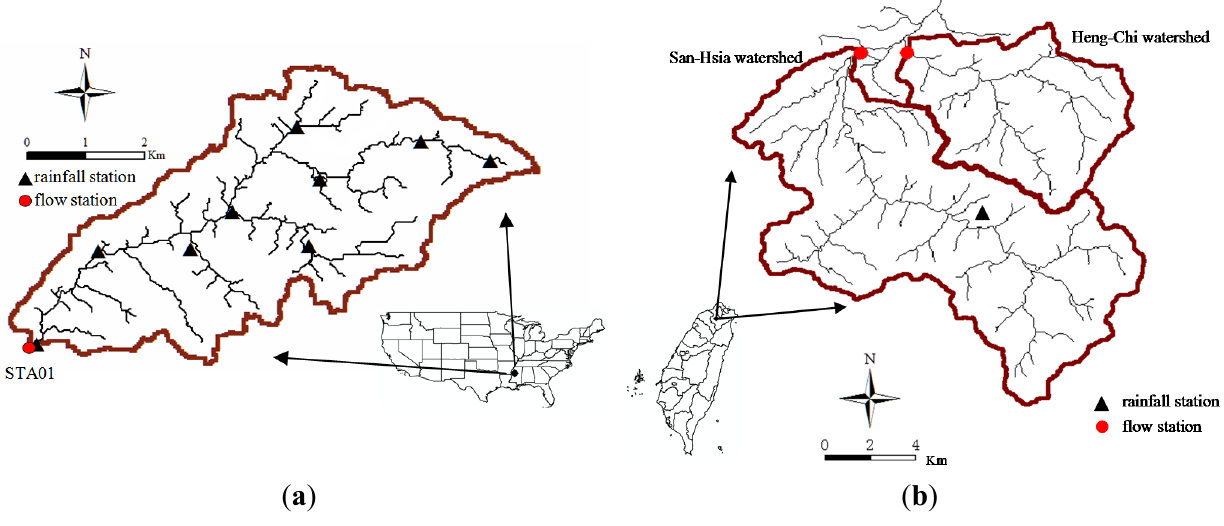
Figure 2. Watershed boundary and channel network of the study watersheds: ( a ) Goodwin Creek watershed; ( b ) Heng-Chi and San-Hsia watershed.